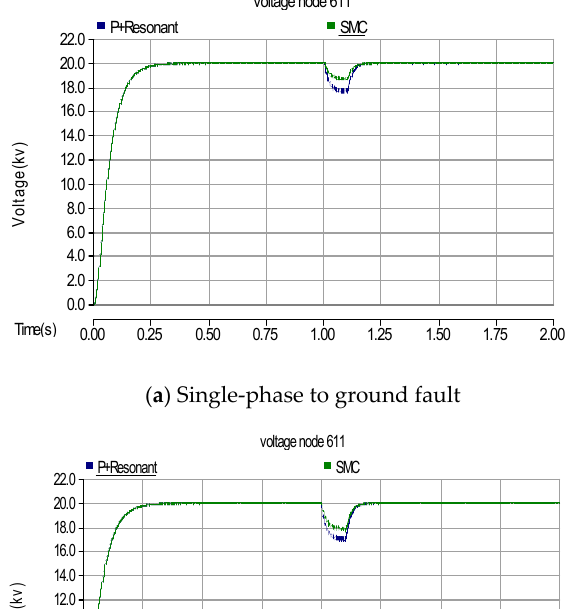
( b ) three-phase to ground fault Figure 8. Voltage domain variations in bus 611 due to symmetrical short circuit faults in bus 671 and compensation with P+Resonant and SMC control systems. To compare the effectiveness of the SMC, simulation results of these two control systems are presented in Table 3. Comparison of these figures and tables indicates that in using the SMC system, the voltage sags due to the different short circuit faults are reduced by 100% if the domain of the voltages are in the range of d < 0.1 and 0.3 < d < 0.6; in addition, the fault domain lies in the range of 0.6 < d < 0.9. Thus, this reduces the impacts of the voltage sag. So, compensation using DSTATCOM has led to a 59.88% improvement in voltage quality. The level of this reduction depends on the type